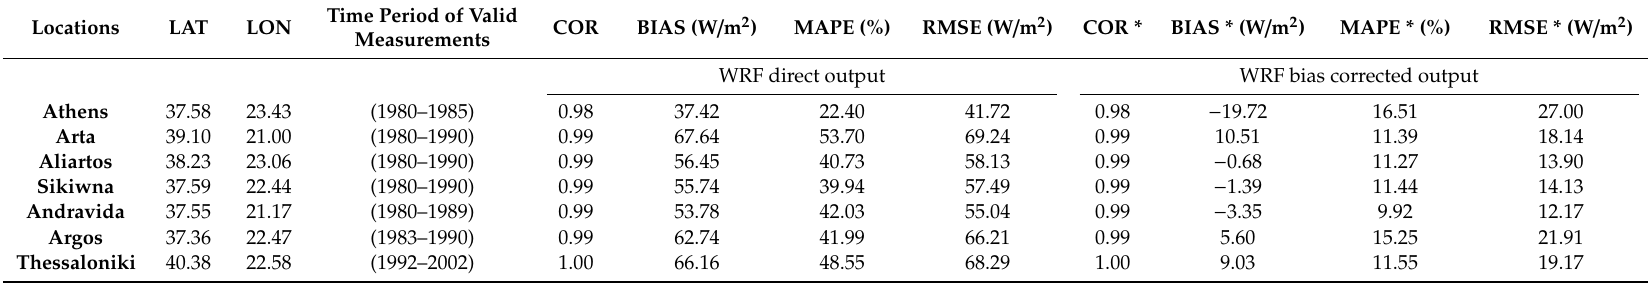
Table 1. Statistical comparison between Weather Research and Forecasting (WRF) climatology, European Climate Assessment (ECA) dataset, and the corrected (*) with the average bias WRF